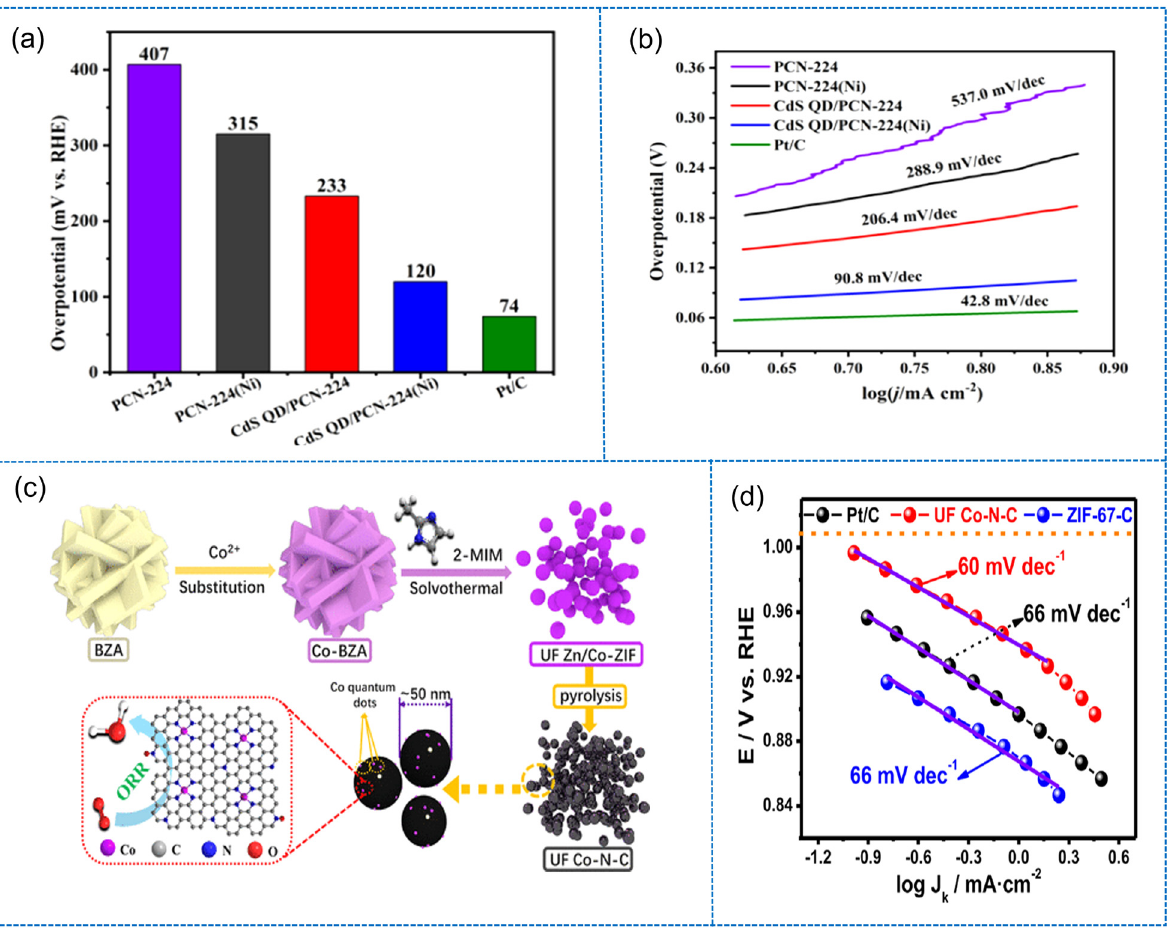
Figure 9: ( a ) Overpotential of PCN - 224, PCN - 224 ( Ni ) , CdS@PCN - 224, CdS@PCN - 224 ( Ni ) , and Pt/C electrodes at the current density of 10 mA cm − 3 . ( b ) Tafel plots of PCN - 224, PCN - 224 ( Ni ) , CdS@PCN - 224, CdS@PCN - 224 ( Ni ) and Pt/C [ 180 ] . ( c ) Illustrative representation of the imitation process of UF Co – N – C. ( d ) ORR e ffi ciency in O 2 - saturated environment 0.1 M KOH electrolyte [ 192 ]